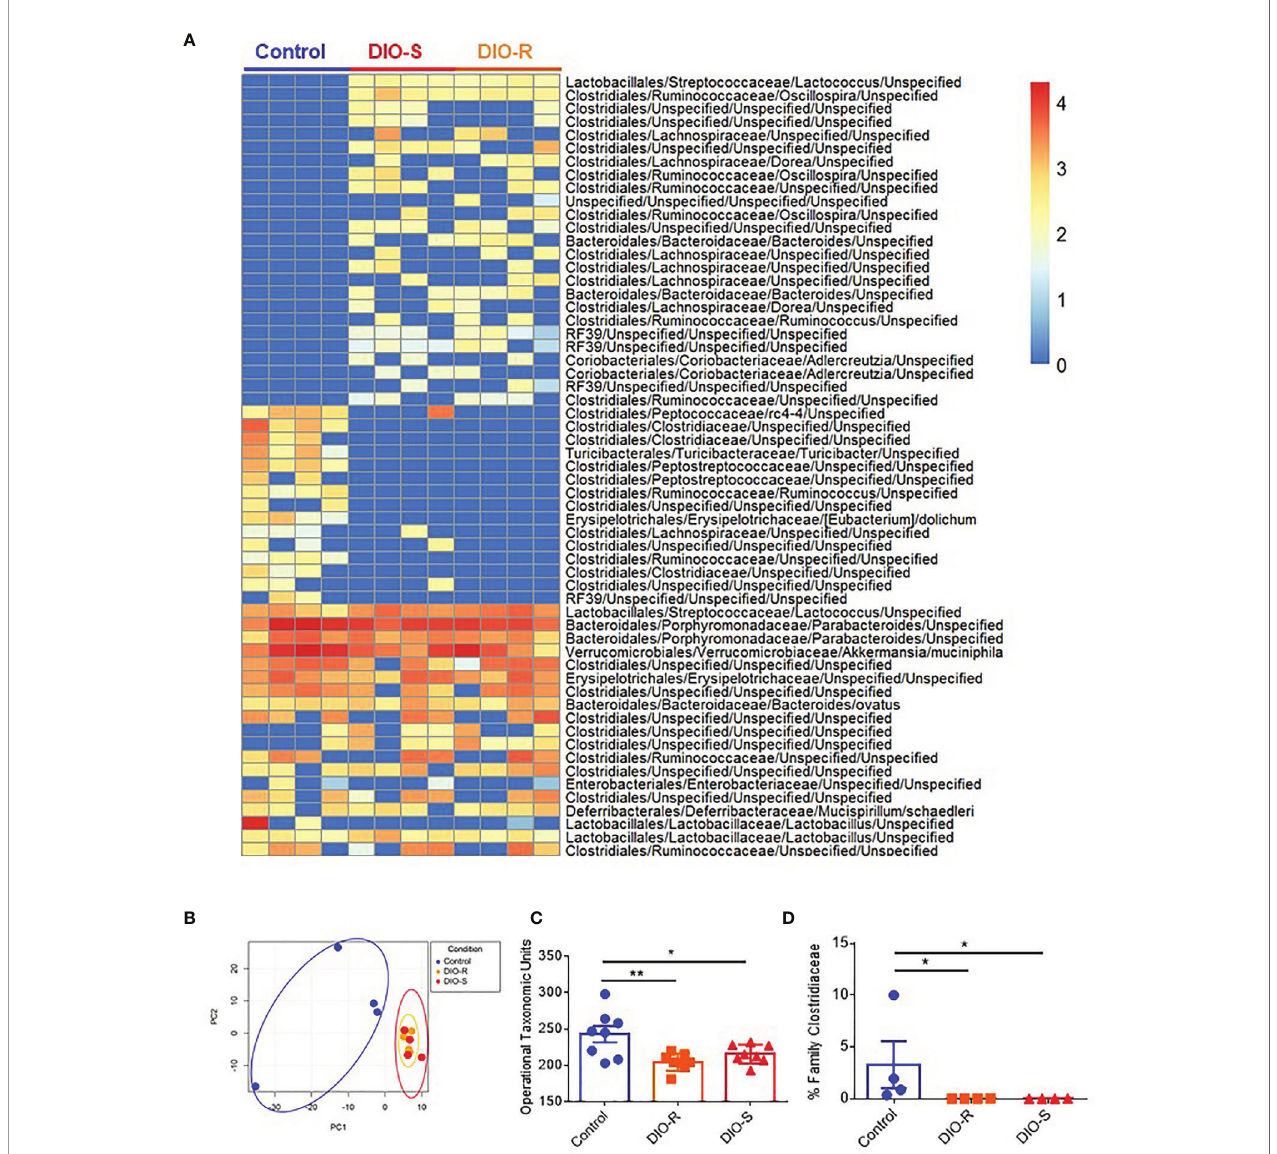
FIGURE 3 | (A) Taxonomic pro fi les of resting control, DIO-R, and DIO-S BALB/c mice (n=4/group). (B) Principle component analysis (PCA) of microbiome pro fi les of control, DIO-R, and DIO-S BALB/c mice (n=4/group). (C) Operational taxonomic units (OTUs) in control, DIO-R, and DIO-S BALB/c mice (n=8/group). (D) Abundance of family Clostridiaceae of control, DIO-R, and DIO-S BALB/c mice. Bar graphs depict mean ±s.e.m. One-way ANOVA test was used in (C, D) . *p < 0.05, **p <